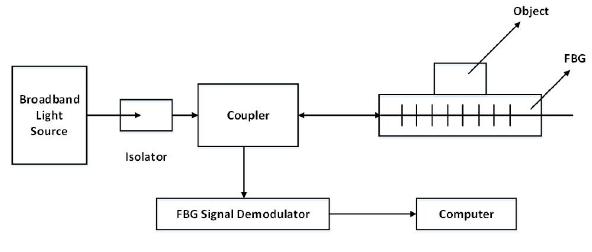
Figure 13. Schematic diagram of the dynamic detection system.